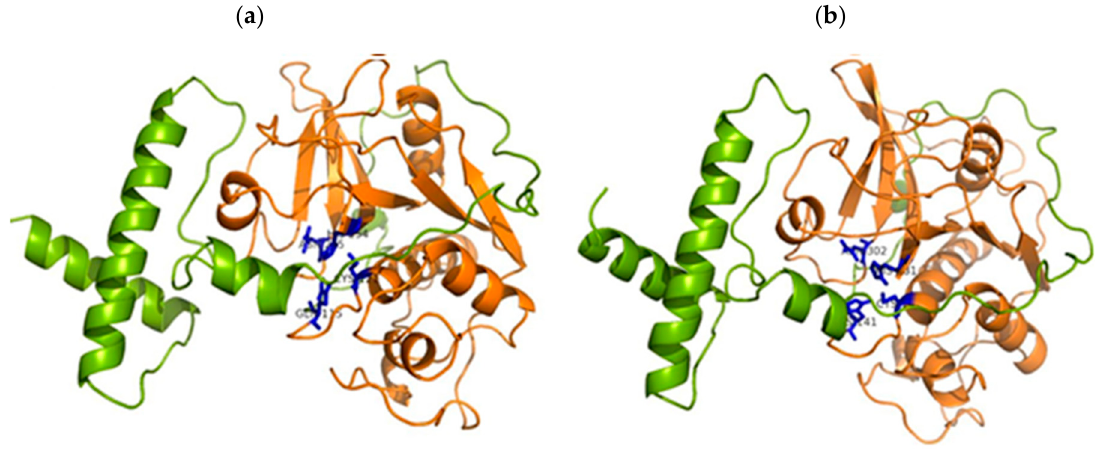
Figure 1. Model domain organisation of ( a ) fruit bromelain (sequences with the accession number of BAA21848 in the NCBI Genbank database and 352 amino acids) and ( b ) stem bromelain (sequences with the accession number of CAA08861 in the NCBI Genbank database and 357 amino acids). α -helix domain (domain I29 at the N-terminal region) is colored in green, β -sheet domain (domain peptidase C1 at the C-terminal region) is colored in orange. The catalytic amino acids of both models are represented as sticks (Reproduced with permission from [13], Elsevier, Amsterdam, The Netherlands, 2018).